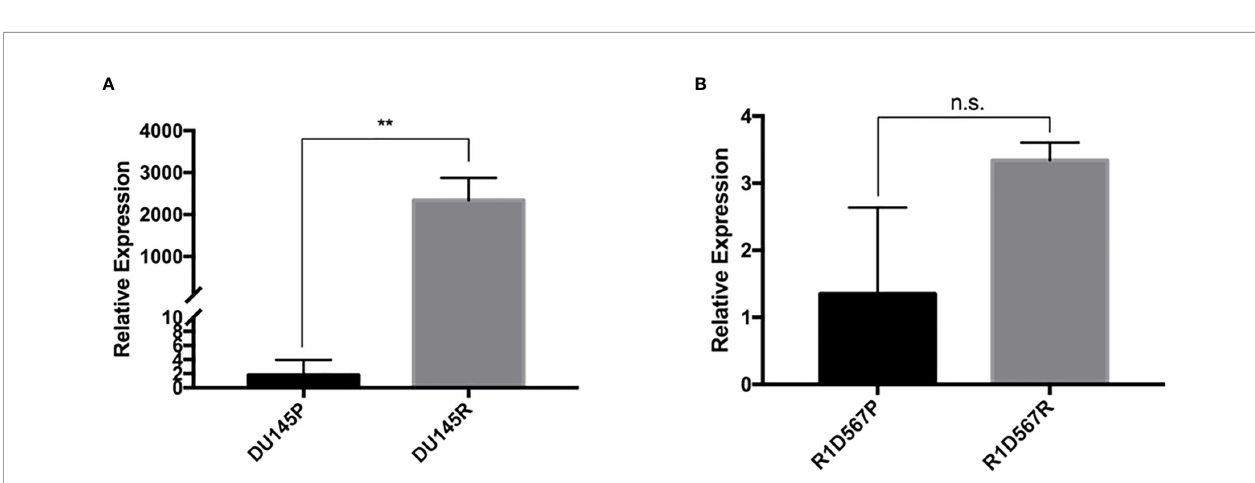
FIGURE 4 | In vitro validation of ABCB1 dysregulation in docetaxel response in CRPC cell lines. The expression was measured using real-time RT-PCR and was normalized to GAPDH expression. (A) Comparison of relative ABCB1 expression levels in DU145 parental line (black bar) and docetaxel resistant line (grey bar). (B) Comparison of relative ABCB1 expression levels in R1D567 parental line (black bar) and docetaxel resistant line (grey bar). ** P < 0.01, n.s., not signi fi